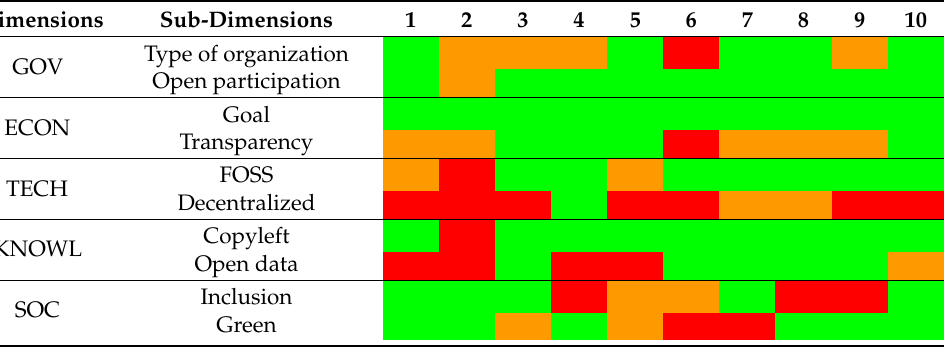
Table 2. Case comparison between the cases of the commons balance. Green: fulfilment, Orange: Partial fulfilment; Red: unfulfillment. Cases: (1) El Recetario; (2) SmartIB; (3) Goteo; (4) Katuma; (5) Bdtonline; (6) XOBB; (7) FreeSound; (8) eReuse; (9) Sentilo; (10) Pam a